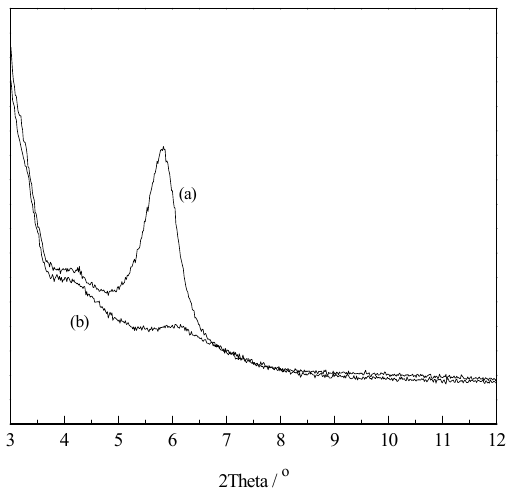
Figure 2. X ‐ ray Diffraction (XRD) patterns of: ( a ) MT; and ( b ) LMT nanocomposite.